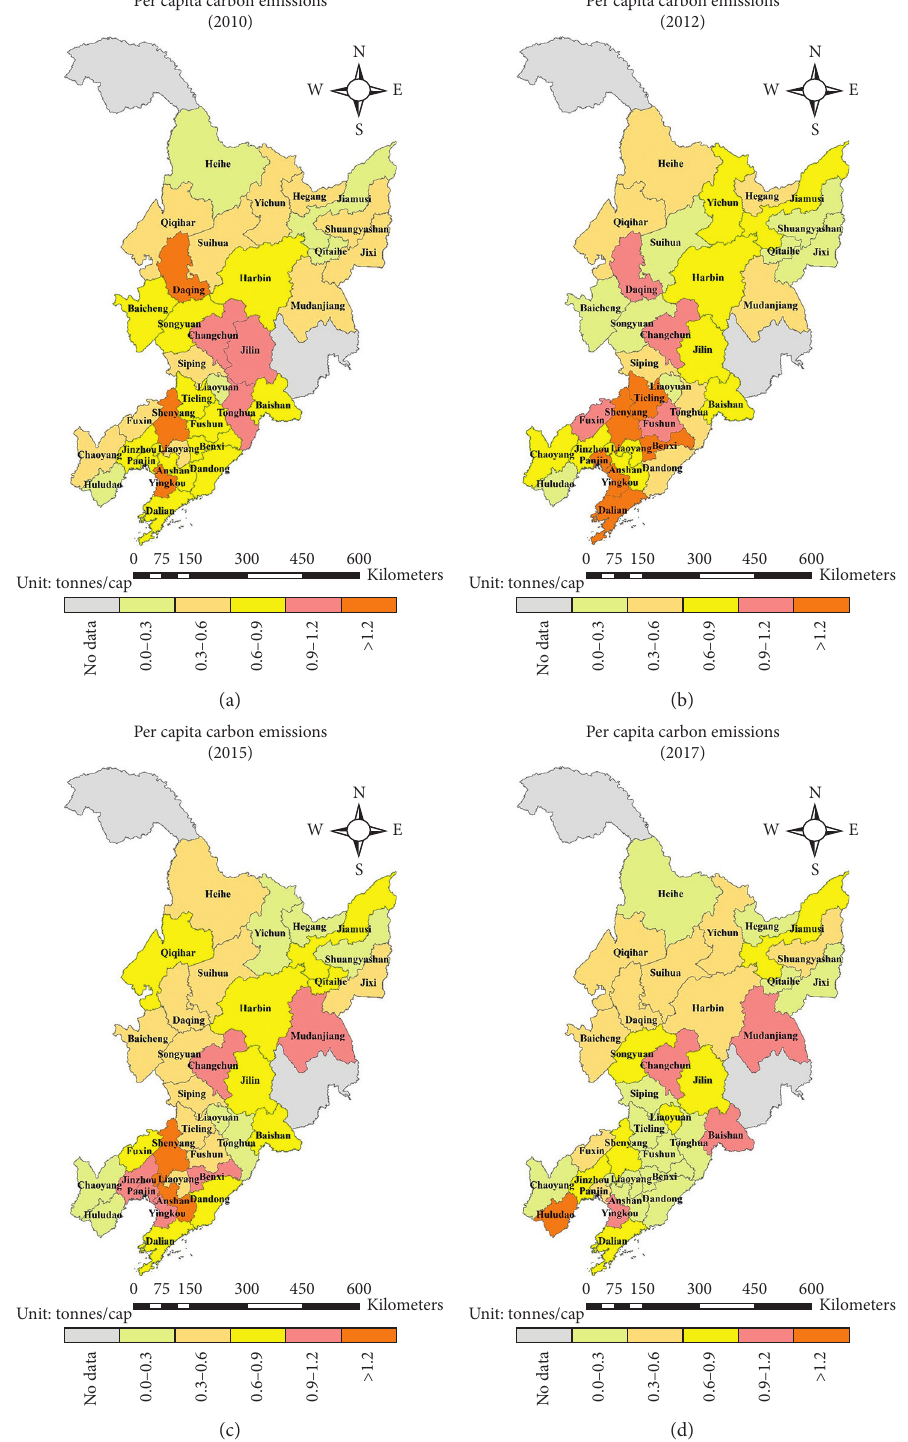
Figure 9: Spatial patterns of total per capita CO 2 emissions of infrastructure construction of 34 cities in Northeast China in 2010, 2012, 2015, and